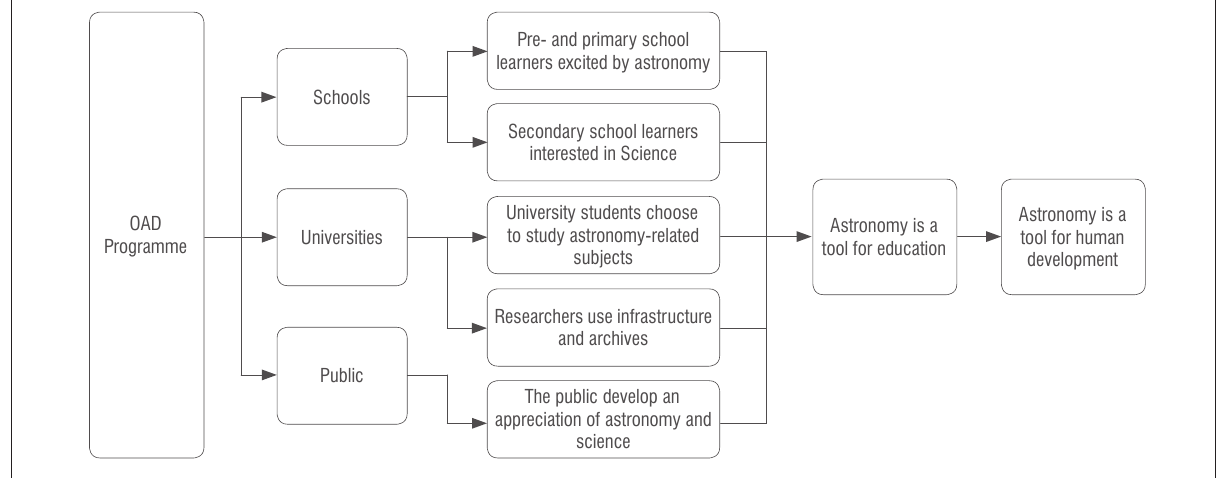
Figure 1: High-level variable-oriented programme theory for the Office of Astronomy for Development